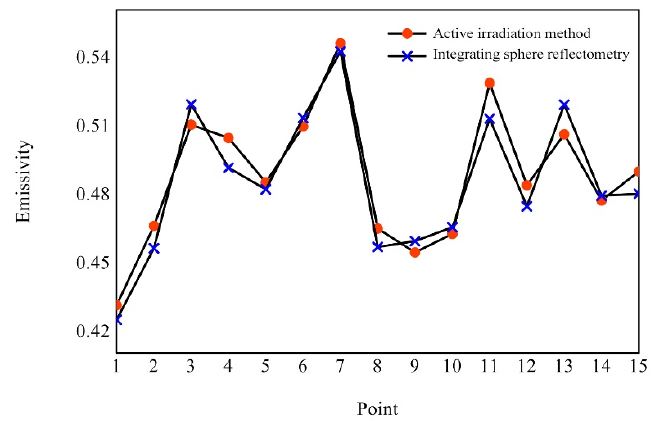
Figure 13. Comparison diagram of measurement results of target area.